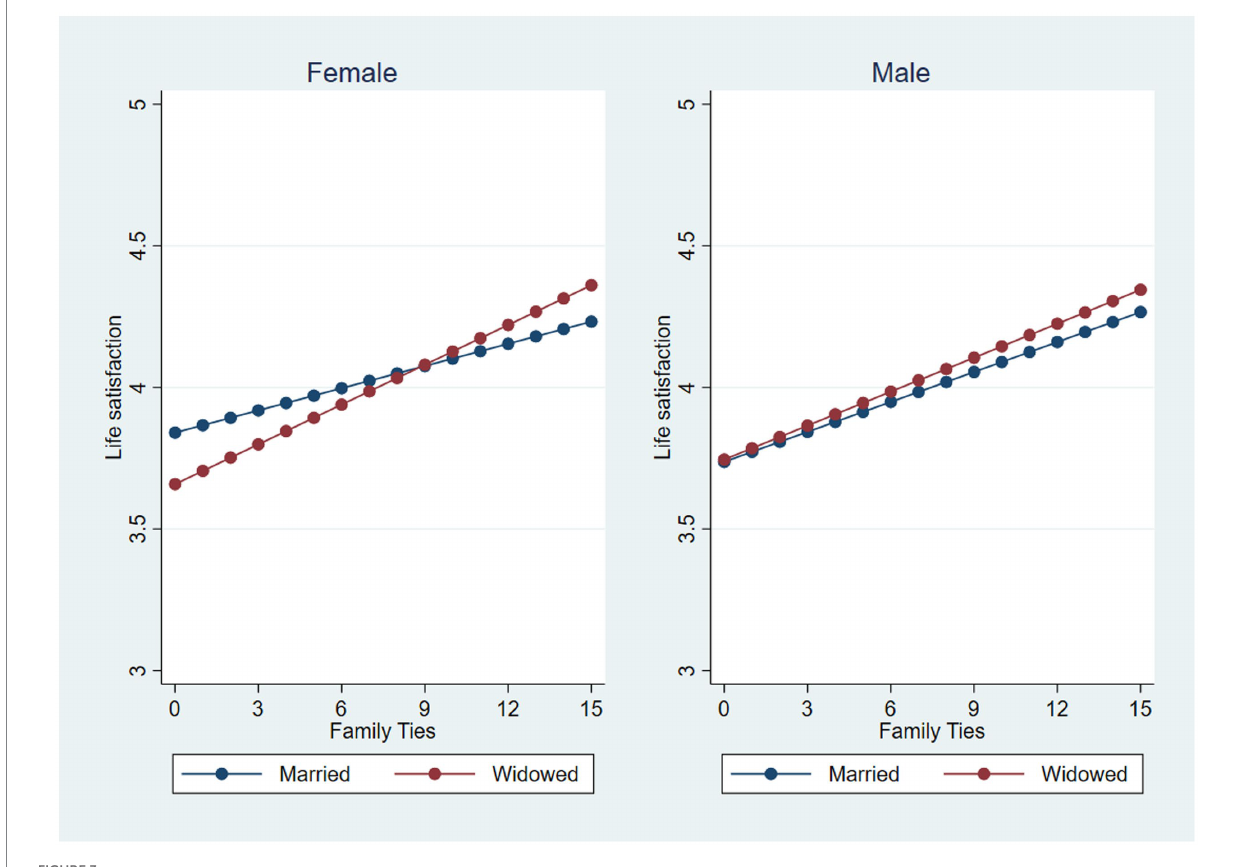
FIGURE 3 The moderating effect of family ties on the widowhood and life satisfaction association among female and male older